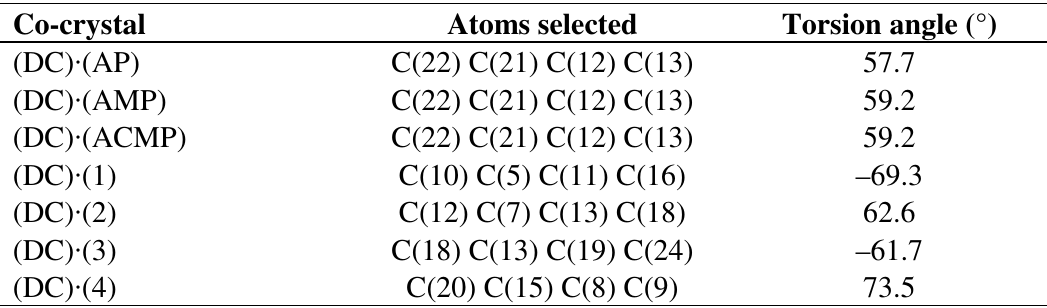
Table 5. Torsion Angles for Diclofenac